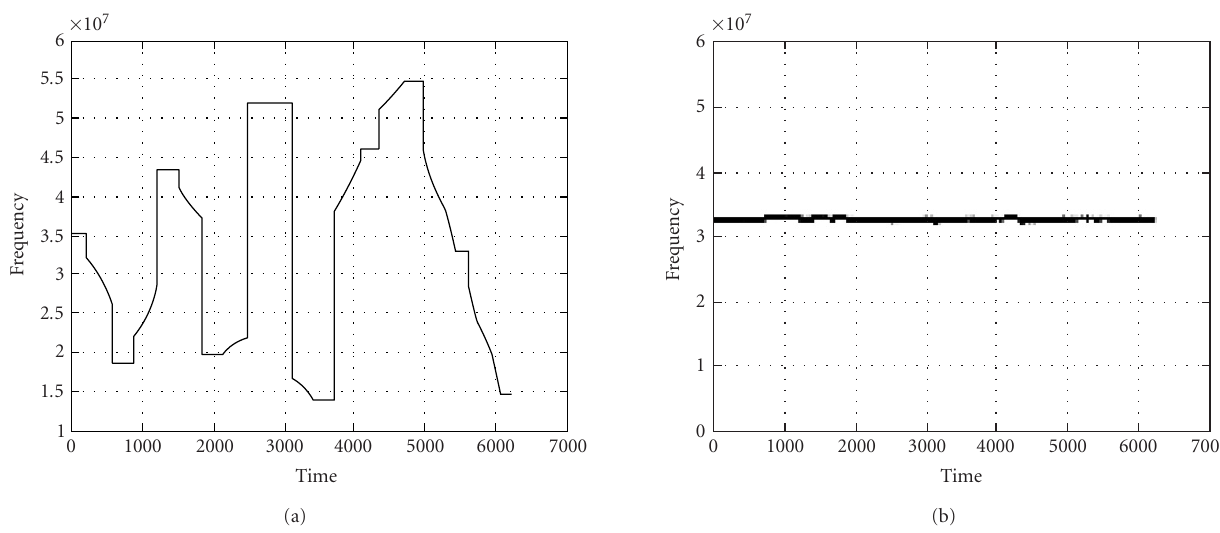
Figure 4: Examples of the first-order conditional moments, namely the instantaneous frequency, in the cases of (a) Bluetooth (frequency hopping) and (b) IEEE 802.11b